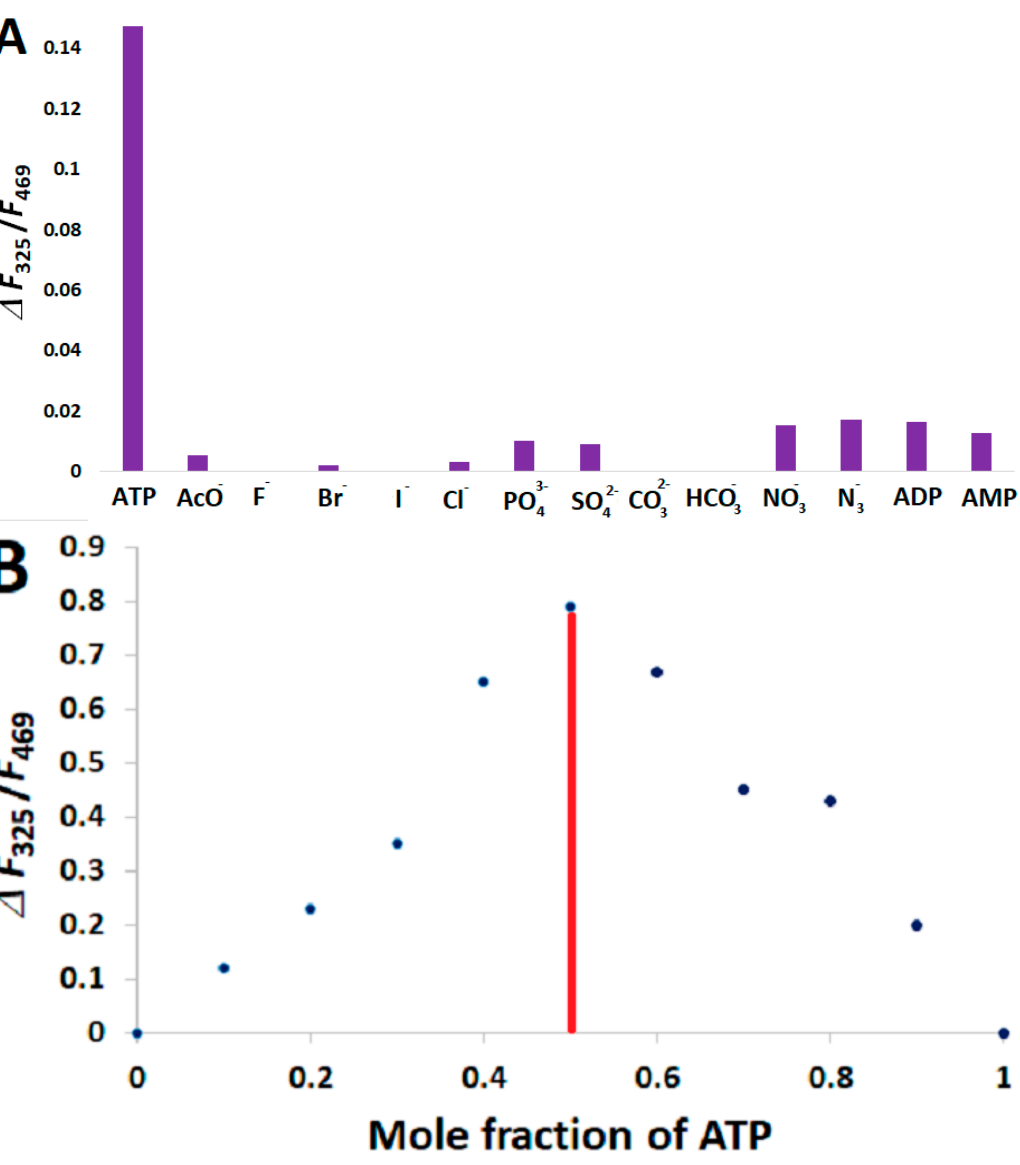
Figure 5. ( A ) The change in F 325 / F 469 ratio of probe 5 in the presence of various anions in HEPES buffer (pH 7.5). ( B ) Job plot of 5 and ATP binding indicating 1:1 (5:ATP) binding stoichiometry. The relative concentrations of 5 and ATP were varied while the total concentration [5 + ATP] remained constant (10 μ M).